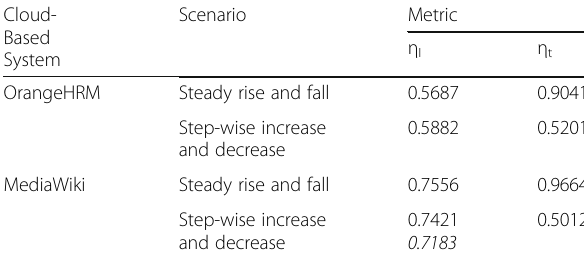
Table 5 Scalability metrics values Cloud- Based